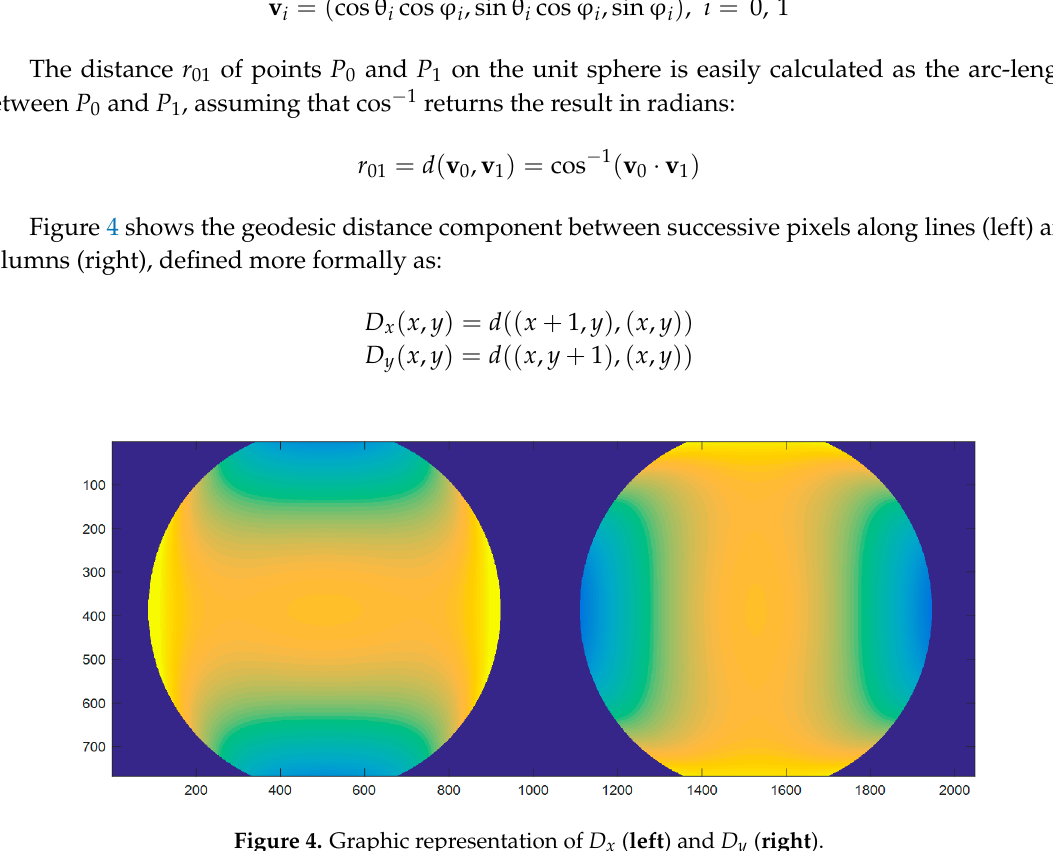
Figure 4. Graphic representation of D x ( left ) and D y ( right ).